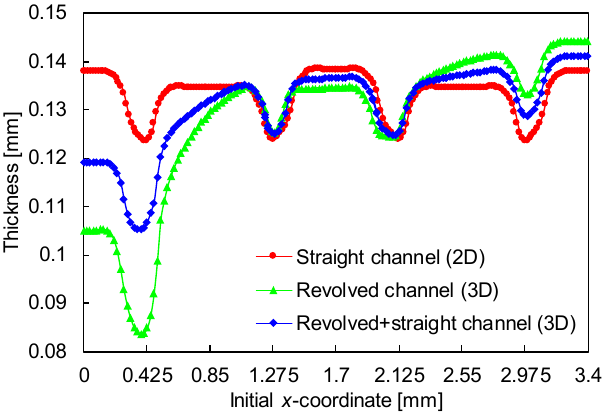
Figure 17. Thickness distribution in a single channel at y = 0 for the three different models. The parameters are w 1 = s = 1.2 mm, r = R = 0.3 mm, and h = 0.7 mm.